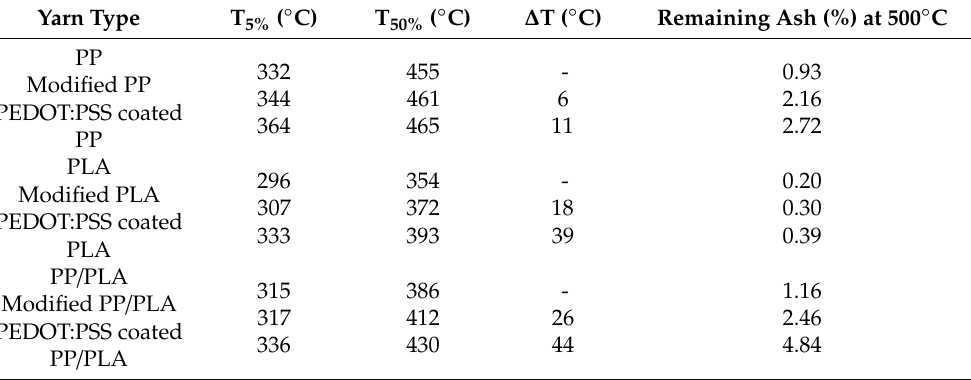
Table 4. TGA results of conductive PP, PLA and PP / PLA: T 5% , T 50%, ∆ T and the remaining ash (%) at 500 ◦